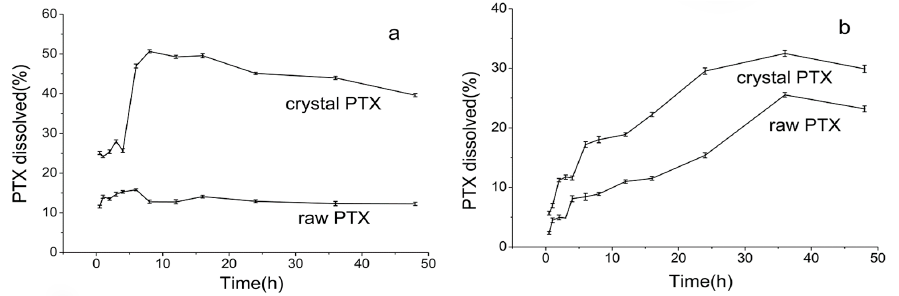
Figure 12. The dissolution profiles of the samples in water ( a ), and in artificial gastric juice ( b ).